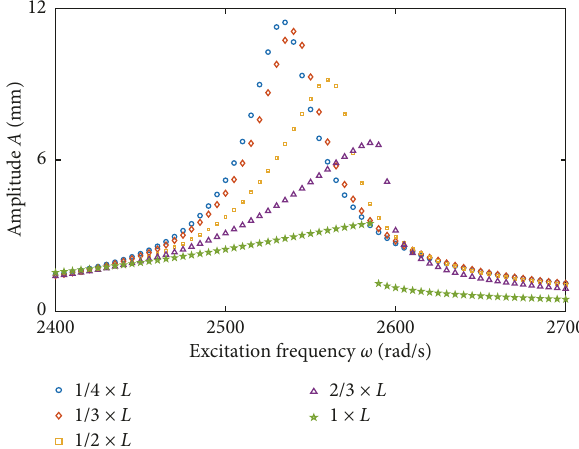
Figure 16: The amplitude-frequency curves at different shroud